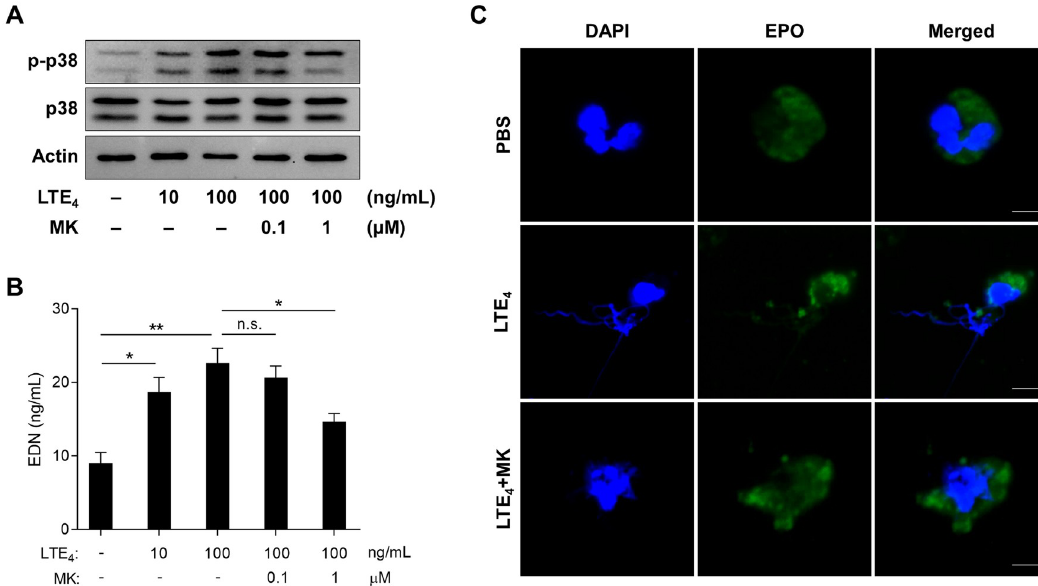
Fig 4. Function of LTE 4 in eosinophil degranulation. (A) Phosphorylation of p38 in peripheral eosinophils (samples from 3 asthmatic patients were pooled). (B) Levels of EDN released from the cells. Data are presented as mean ± SD, n = 5. � P < .05 and �� P < .01 were obtained by the Mann-Whitney test. n.s., not significant. (C) Images of eosinophils observed using confocal microscopy. Scale bar, 5 μ m. DAPI, 4 0 ,6-diamidino-2-phenylindole (blue); EPO, eosinophil peroxidase (green); MK, montelukast.